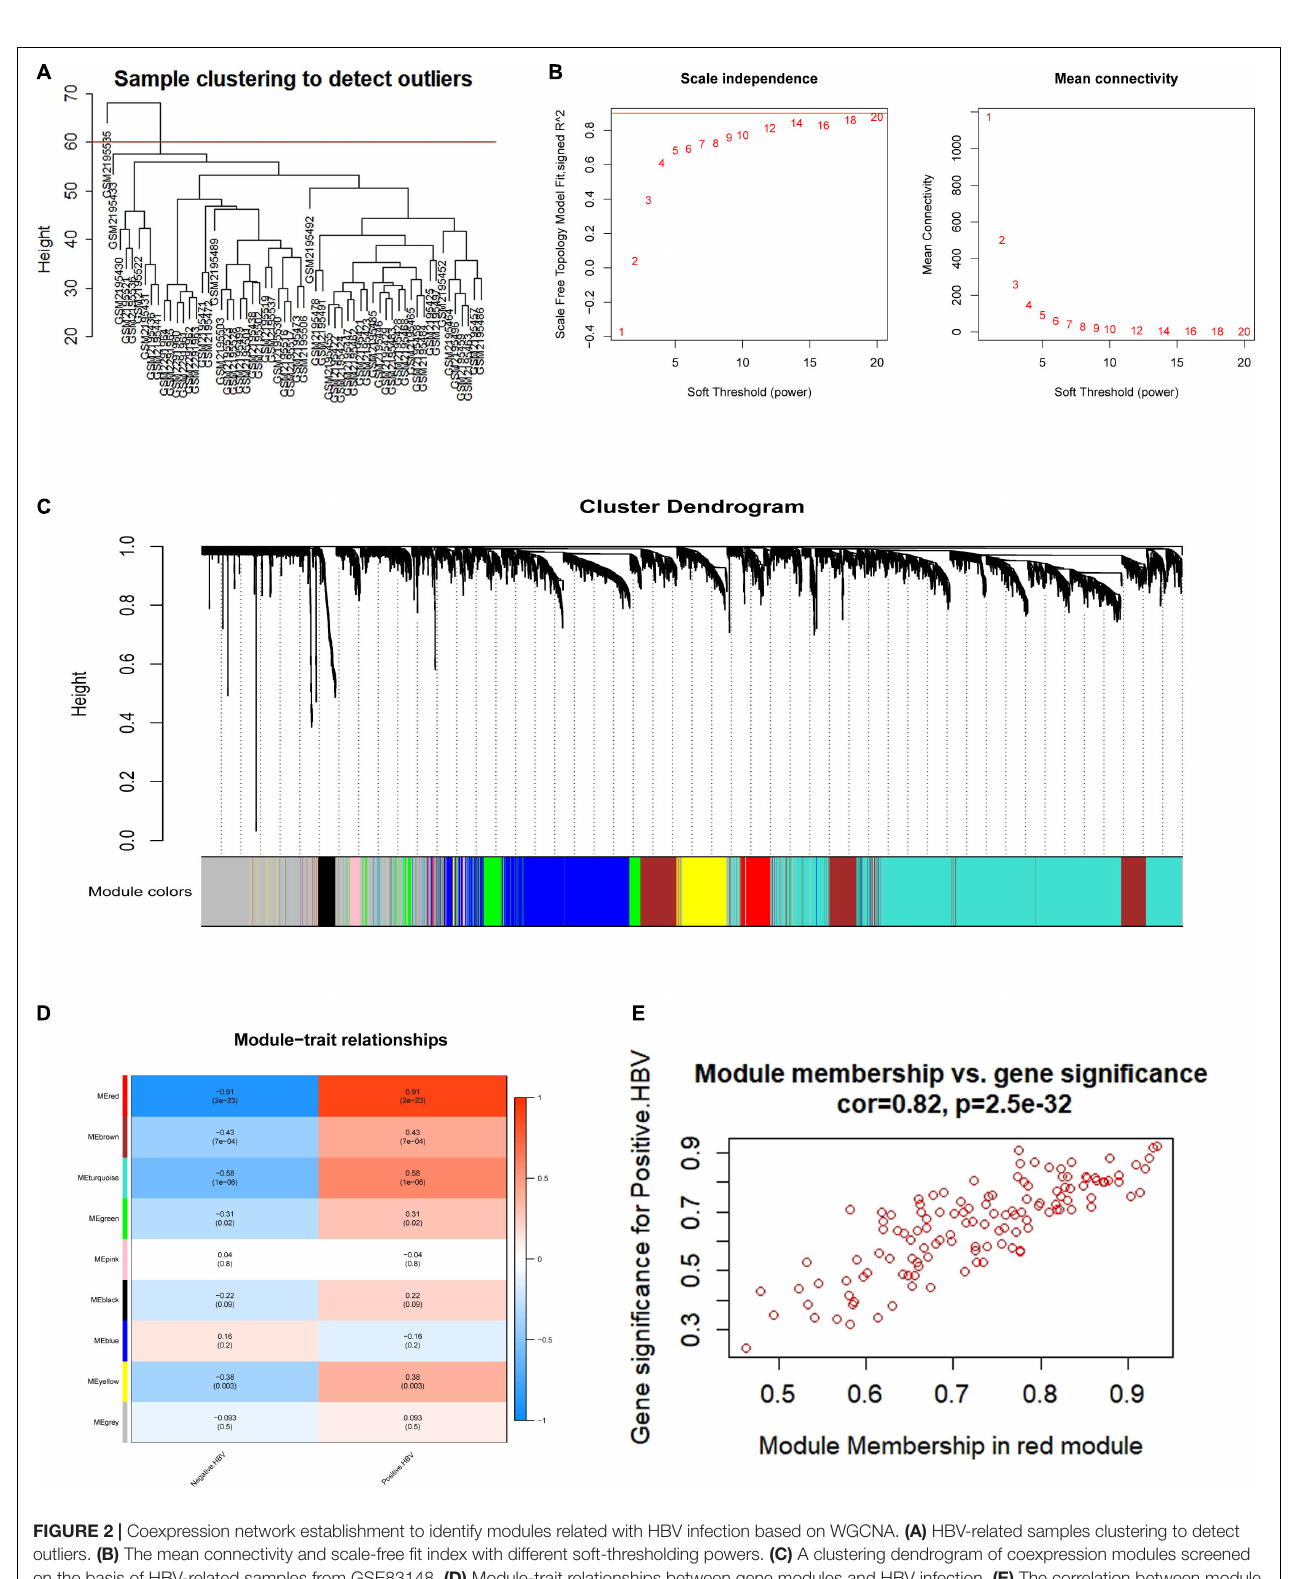
Frontiers in Genetics |